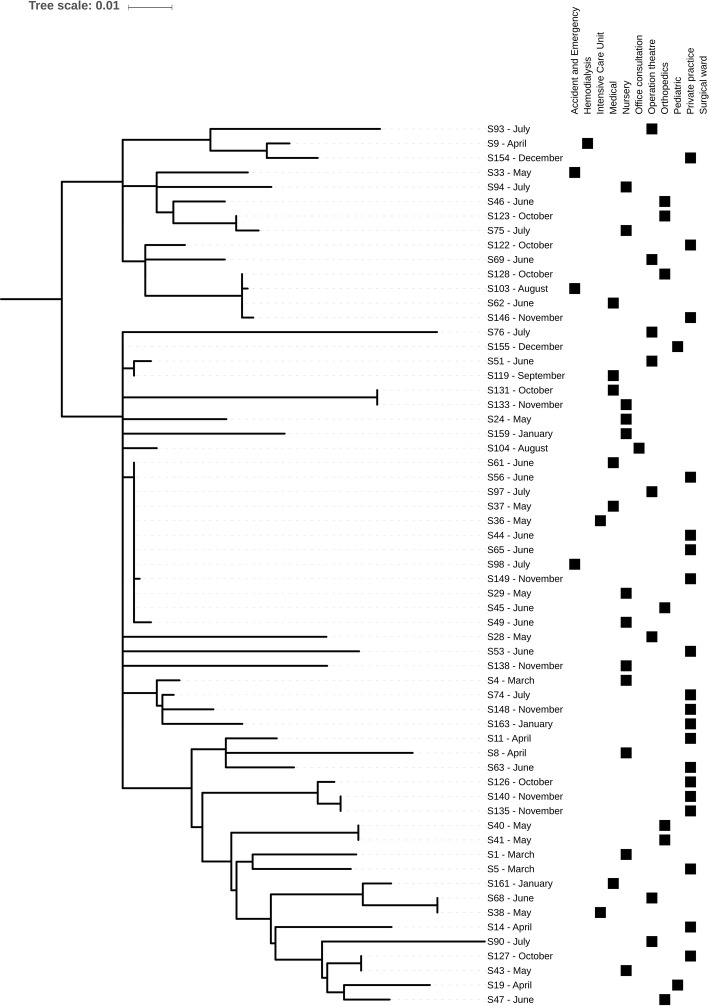
Midpoint-rooted core genome phylogeny of the 61 St. Kitts and Nevis ST8 MRSA isolates using the chromosome of methicillin-resistant S. aureus TCH1516, a USA300 reference strain. Phylogeny was based on an alignment of 801 SNPs. Metadata describing sample month and origins is provided.